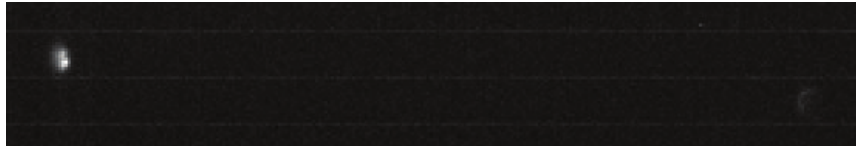
Figure 7: The combined image of ≈ 1200 guiding frames on 51Peg, total exposure time 20 minutes. The bright image to the left is the position of the star as imaged through the beam splitter the fainter image to the right is the light spilled over the fiber entrance and reflected back onto the guider camera. Guiding is done exclusively at the brighter image. Aperture photometry of the combined frame is used to measure the amount of light lost, here 32%.